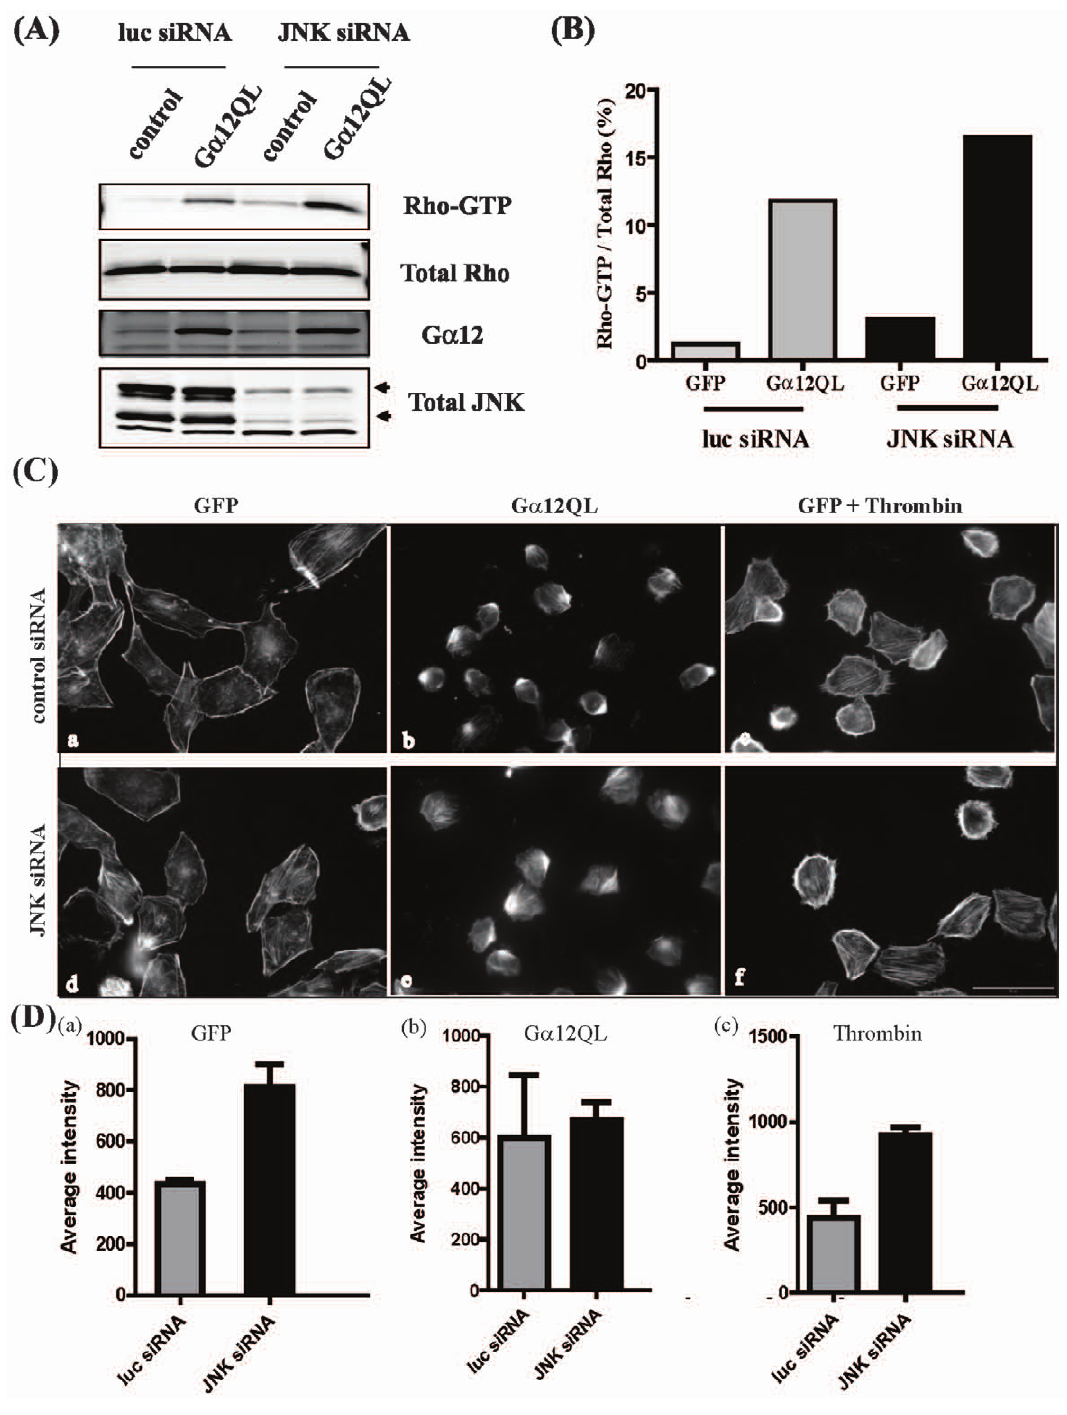
Figure 4. ROCK and JNK signal downstream of G a 12QL-activated Rho. (A) MDA-MB-231 cells were transfected with control (luc) siRNA or JNK siRNA for 3 days prior to infection with GFP (control) or G a 12QL adenovirus for 6–7 h. Cells were starved for , 18 h and lysed. Lysates were subjected to pull-down assays using a GST fusion construct of the activated RhoA-binding domain of rhotekin, and levels of precipitated Rho-GTP were determined by immunoblot analysis using anti-RhoA antibody. Total levels of RhoA, G a 12 and JNK in the lysates are also shown. (B) The data in the anti-Rho immunoblots shown in (A) was quantified by plotting the intensities as percentage of activated Rho to total Rho for each sample. (C) MDA-MB-231 cells were plated on coverslips and transfected with siRNA as stated above, prior to infection with GFP (control) ( panels a , d ) or G a 12QL ( panels b , e ) adenovirus. Cells were starved for , 18 h, and those in two conditions ( panels c , f ) treated with 1 U/ml thrombin for 10 min as indicated before all cells were fixed and stained with rhodamine-phalloidin to visualize actin (see Materials and Methods ). Representative images for each condition are shown. Bar, 50 m M. Each panel shows the results of a single experiment that is representative of three independent experiments. (D) Fluorescence intensities of rhodamine-phalloidin staining were quantified using MetaMorph 7.5 software. Average fluorescence intensities are plotted as mean 6 SE for data from two slides imaged with the same exposure time for every condition shown; , 220 cells ( panels a , c ), and , 120 cells ( panel b ) quantified per slide. doi:10.1371/journal.pone.0026085.g004 PLoS ONE |